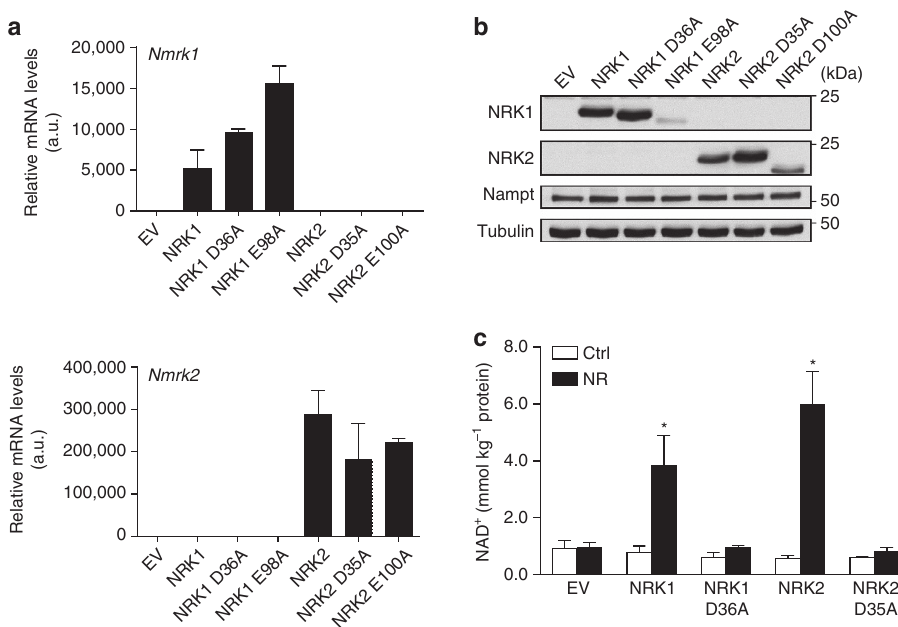
Figure 1 | NRKs are rate-limiting for NR-driven NAD þ synthesis. ( a , b ) NIH/3T3 cells were transfected with 4 m g of Flag-tagged WT and catalytically inactive version of NRK1 or NRK2 overexpressing vector. Nmrk1 and Nmrk2 mRNA ( a ) and NRK1/NRK2 protein ( b ) expression. ( c ) NAD þ measurement in NR-treated NIH/3T3 cells overexpressing NRK1 or NRK2. Results shown are mean ± s.e.m.; EV, empty vector; * P o 0.05 versus ctrl by two-sided unpaired T -test ( n ¼ evaluated the role of NRK1 in the utilization of other NAD þ